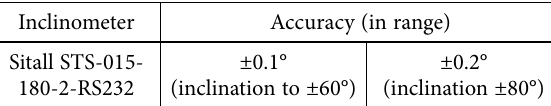
Table 2. Accuracy inclinometer featured by